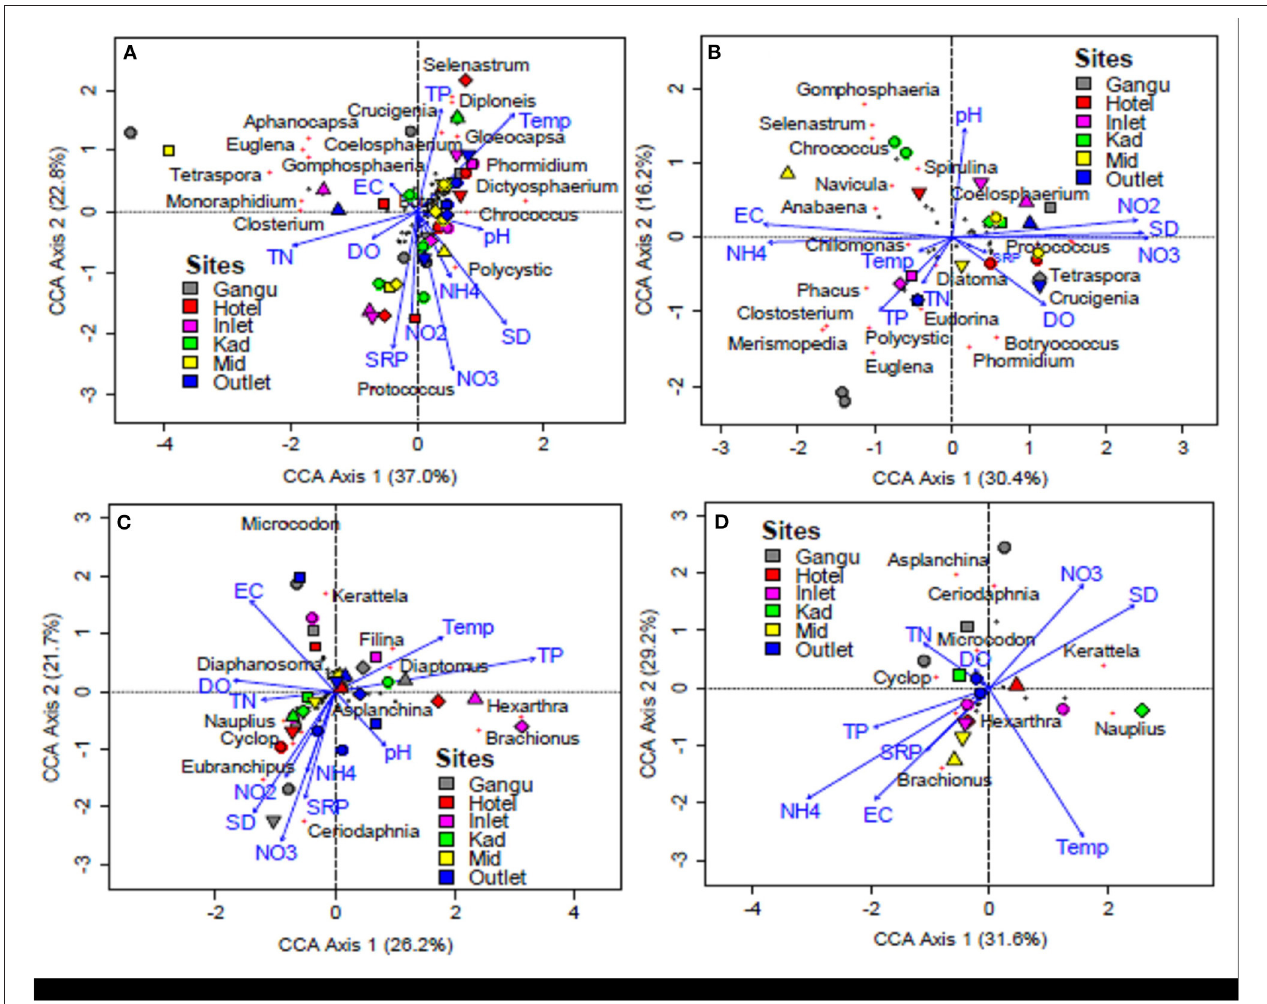
FIGURE 6 | Canonical correspondence analysis (CCA) between plankton and physico-chemical variable among sites in Lake Kanyaboli from February 2020 to February 2021. (A,B) phytoplankton site comparisons, (C,D) zooplankton site comparisons. KAD, Kadenge; MID, Open water. 2003; Fonseca and Bicudo, 2010). Therefore, the lake is